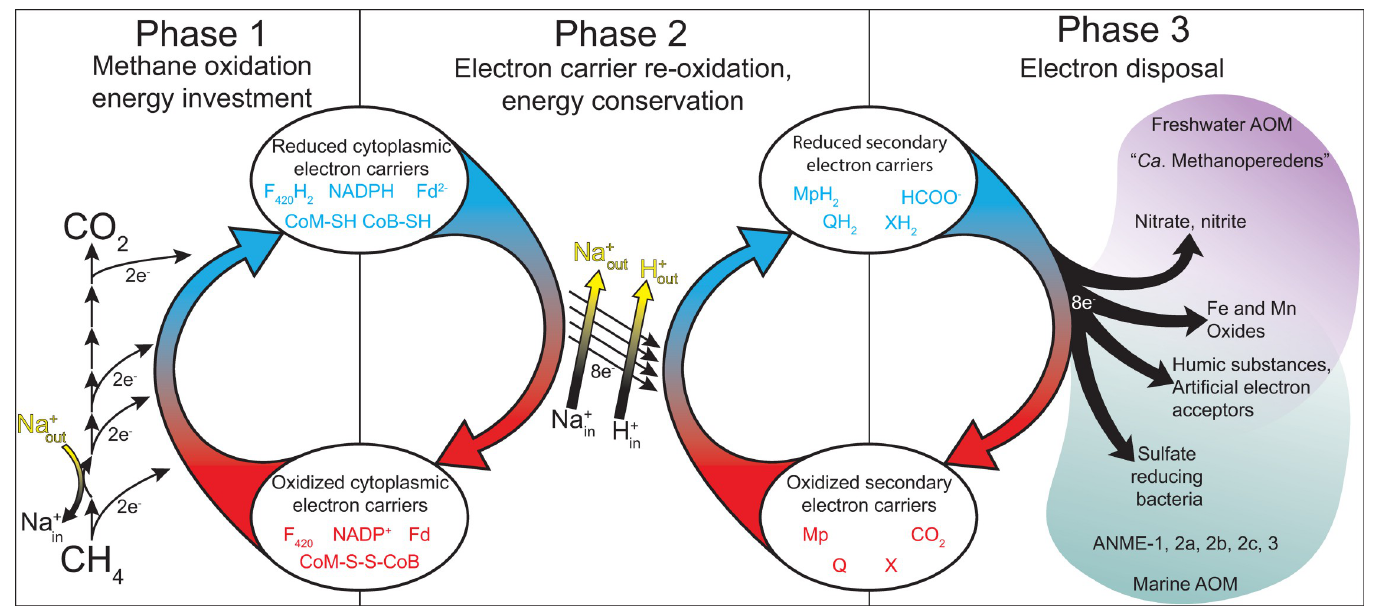
Fig 2. Summary of ANME energy metabolism. Schematic representation of the 3 phases of ANME energy metabolism in our current model. In Phase 1, methane is oxidized to CO 2 through the reversal of the canonical seven step methanogenesis pathway. Energy is invested in this phase in the form of sodium ion translocation from the outer face of the cytoplasmic membrane to the inner face (yellow arrow). As C1 moieties are sequentially oxidized, 8 electrons are transferred to soluble electron carriers such as F 420 H 2 , NADPH, Fd 2 − , and CoM-SH/CoB-SH. In Phase 2, 8 electrons on these primary electron carriers are transferred to secondary electron carriers in a process that conserves energy needed for cell growth in the form of sodium and proton motive forces (yellow arrows). These secondary electron carriers may be quinols (QH 2 ) methanophenazine (MpH 2 ) or possibly soluble electron carriers such as formate (HCOO − ) or an unknown electron shuttle (XH 2 ). In Phase 3, the secondary electron carriers are relieved of their electrons in various ways depending on the environmentally available electron acceptors, which can include SRB in the case of marine ANME-SRB consortia, iron, manganese, or oxidized nitrogen species in the case of “ Ca . Methanoperedens”. Humic substances and artificial electron acceptors (AQDS) have also served as electron acceptors in laboratory experiments for a variety of different ANME from fresh and marine environments. ANME, anaerobic methanotrophic; AOM, anaerobic oxidation of methane; SRB, sulfate-reducing